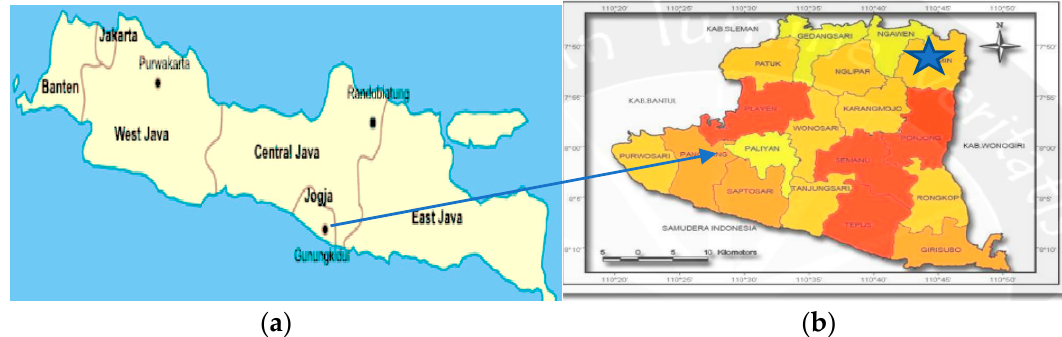
Figure 1. Map showing the location in Java ( a ) the specific study area in Gunungkidul, Yogyakarta ( b ). Composite soil samples were collected in each experimental unit by taking five sam ‐ ples from a 20 cm depth at points along a diagonal line across the unit; soil from the 5 points was mixed, and a 1 kg subsample was taken for laboratory analysis to characterize chemical and physical soil properties [39]. Results indicated the soil in all blocks is a litosol [43], with components for sand, silt, and clay, low organic material, pH of 6, very low total N, very high K availability, and varied P 2 O 5 availability. Litosol soils are formed from volcanic activity, specifically the weathering of igneous rocks and sediments. Litosols soils are suitable for secondary crops and perennials [43]. The soil surface is composed of lime ‐ stone, generally suitable for teak [44]. In some spots, rocky limestone is exposed above the soil surface. Soil characteristics for each block in the trial are presented in Table 1. The soil at the research site has a shallow depth and is sensitive to erosion, resulting in low levels of organic matter. There were no apparent differences in teak silvicultural practices (by farmers) between the good and poor sites [45].